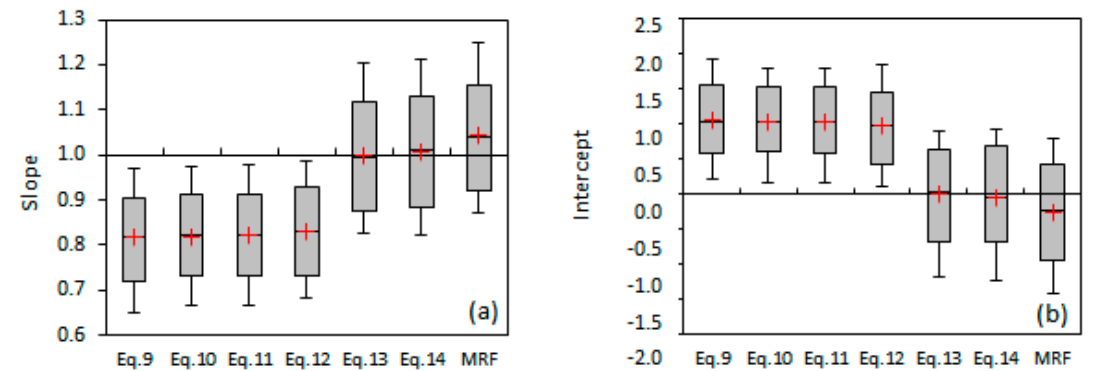
Figure 5. Range of ( a ) slopes and ( b ) intercepts of the trend lines of observed vs. predicted ET o values from 1:1 plots using all the validation cases from the RCV-NLR analysis of Equations (9)–(14) and MRF presented as modified box-whisker plots, with boxes adjusted to the 95% HPD interval (optimum slope equal to 1, and optimum intercept equal to 0; 1:1 plots were constructed with observed values at the vertical and predicted values at the horizontal axis).